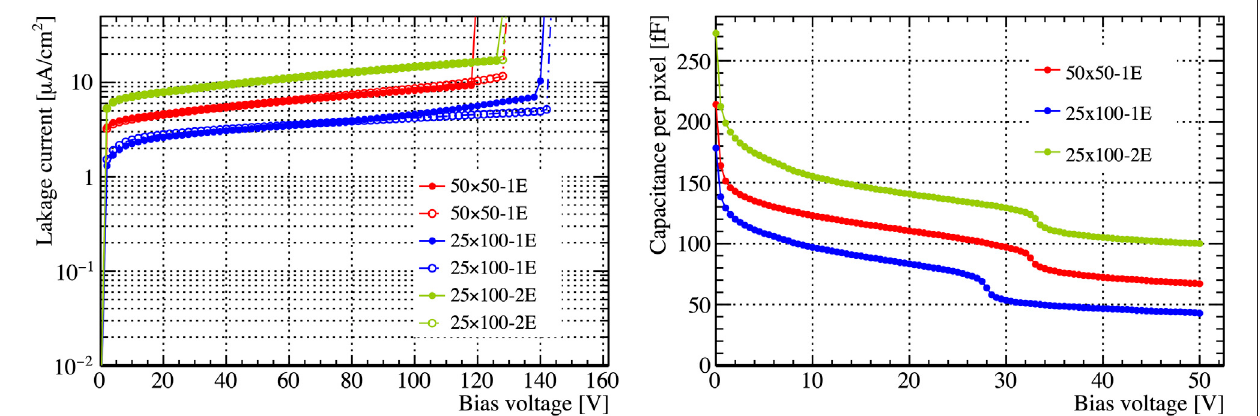
FIGURE 6 | SINTEF 3D diode measurements performed on wafer at the end of the process on the fi nal metal. I-V (Left) and C-V (Right) curves are shown. A systematic uncertainty, not shown in the fi gures, of less than 10% has been estimated for both current and capacitance measurements, due to temperature variations and the LCR circuit, respectively. The systematic uncertainties due to the test instrument for the considered voltage and current range are smaller than 1%.